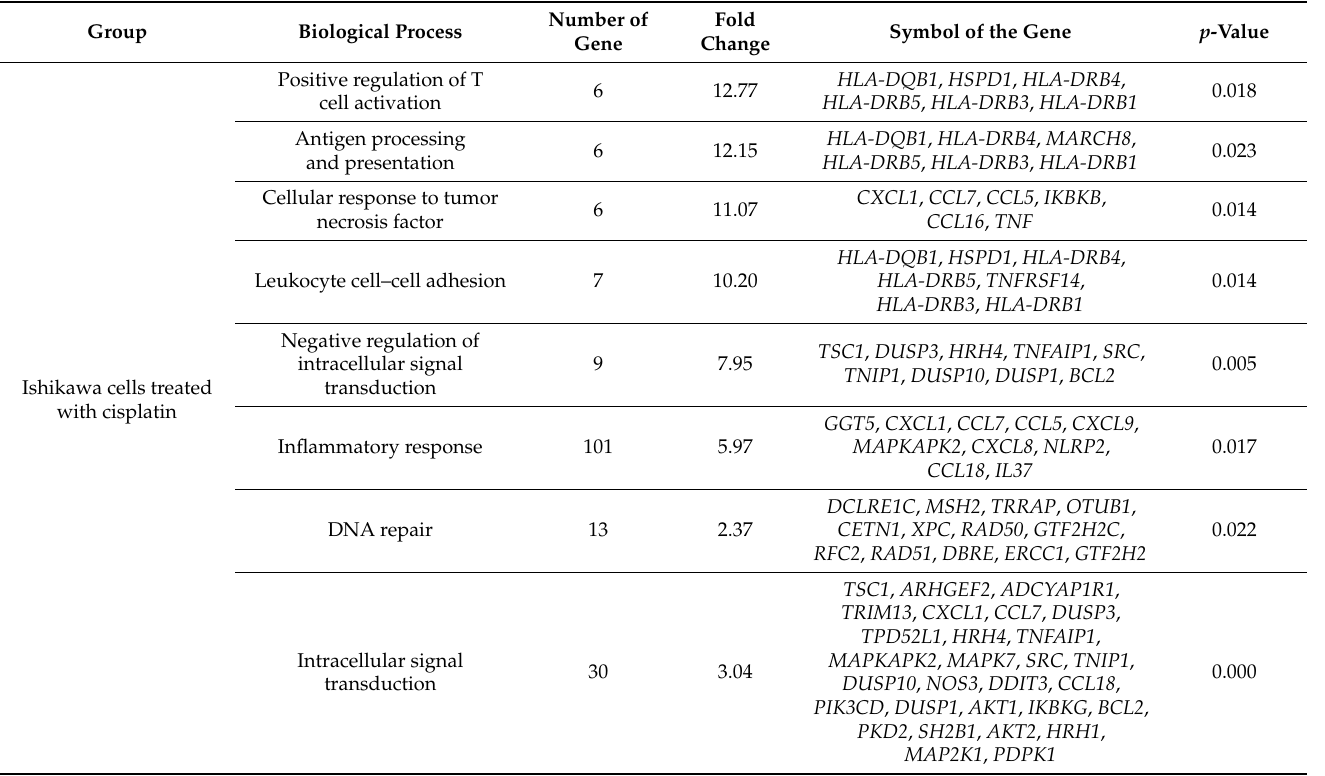
Table A1. Biological processes modulated by genes related to the phenomenon of oxidative stress in Ishikawa cells exposed to cisplatin or